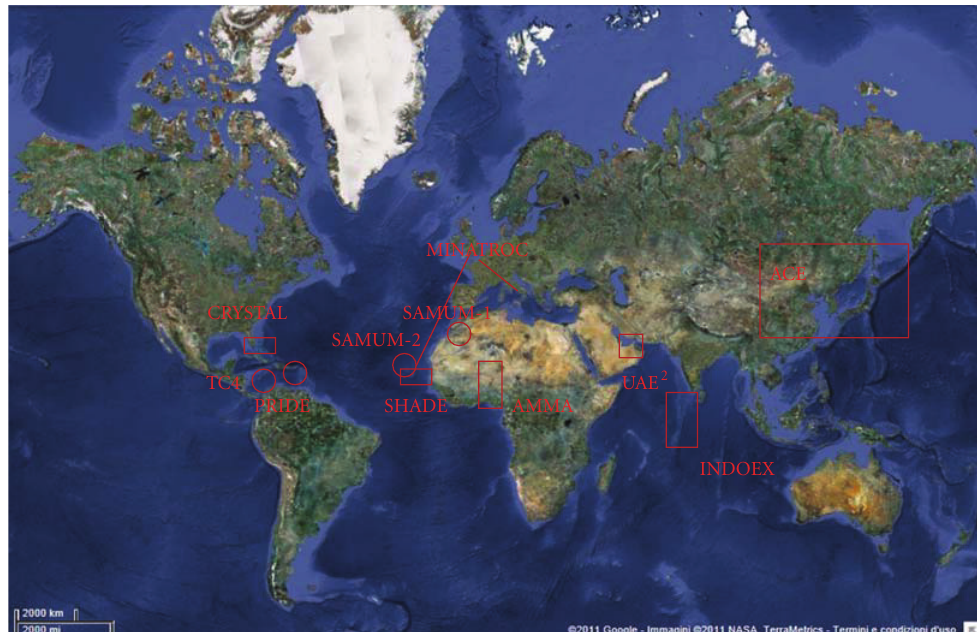
Figure 2: Location of the special measurements campaigns reported in Table